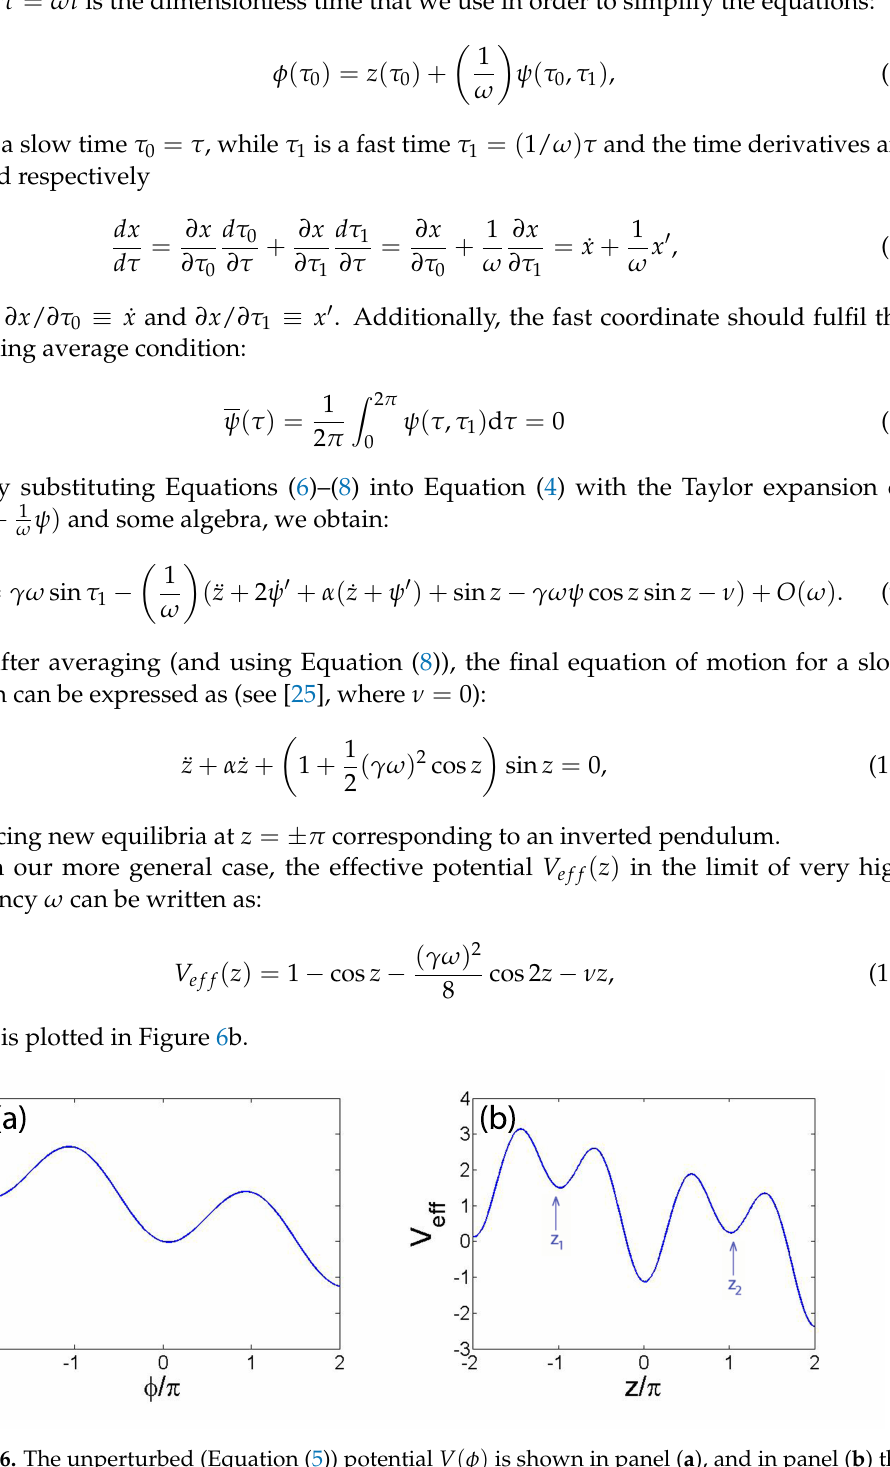
Figure 6. The unperturbed (Equation (5)) potential V ( φ ) is shown in panel ( a ), and in panel ( b ) the effective potential V ef f ( z ) of the vertically excited parametric pendulum with a torque (Equation (11)) in the limit of large ω (for γω = 3) and ν = 0.2. In that case, the fast oscillations stabilize the motion around z ≈ 0 and ± φ (inverted pendulum). The effective potential is asymmetric because of a nonzero torque ν (cid:54) = 0. z 1 and z 2 ≈ π (modulo 2 π ) denote the new minima for the effective potential corresponding to the inverted